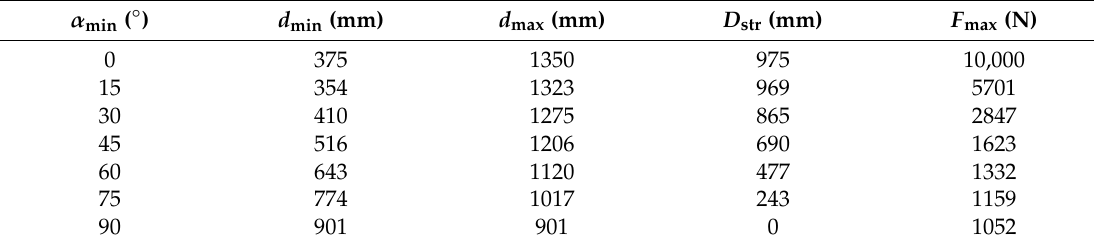
Table 3. Dependence of dimensions and actuator force on the initial rotation angle α min .